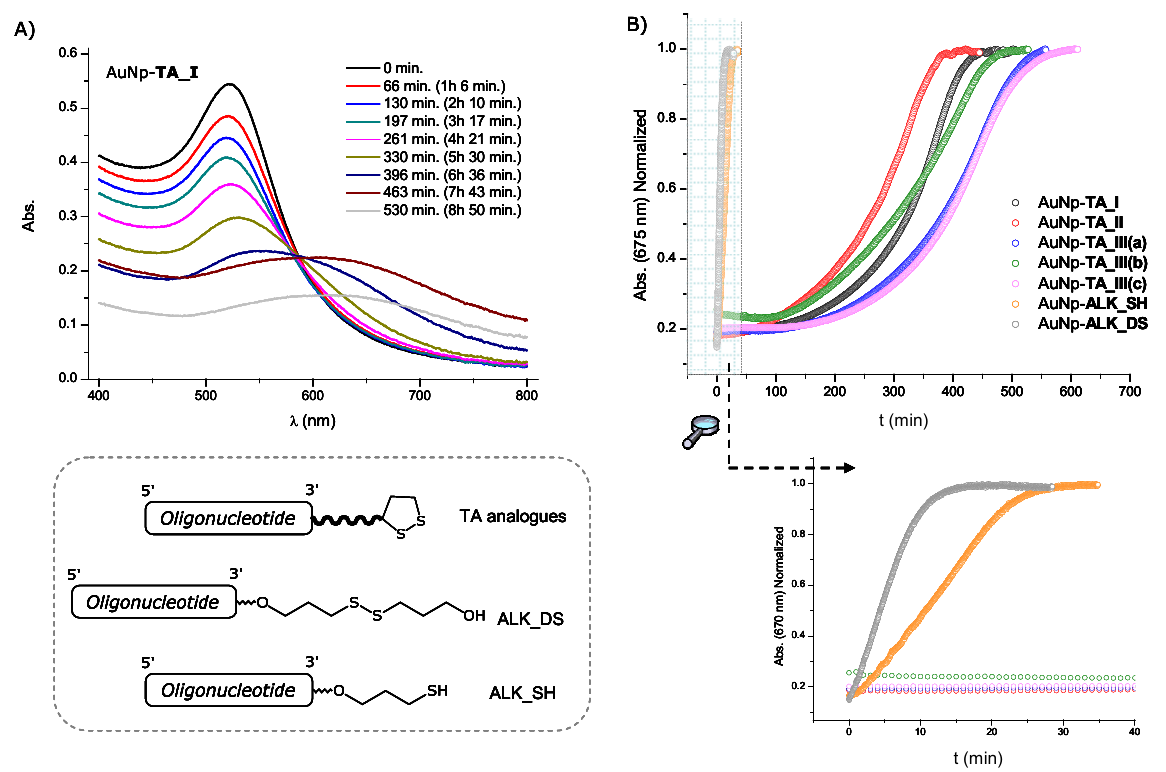
Figure 3. ( A ) Time evolution of UV-Vis spectra of AuNp-TA_I in 100 mM DTT; ( B ) Displacement of modified TA-appended oligonucleotides from AuNPs by measuring the changes in signal intensity at 675 nm with time upon treatment with a 100 mM DTT